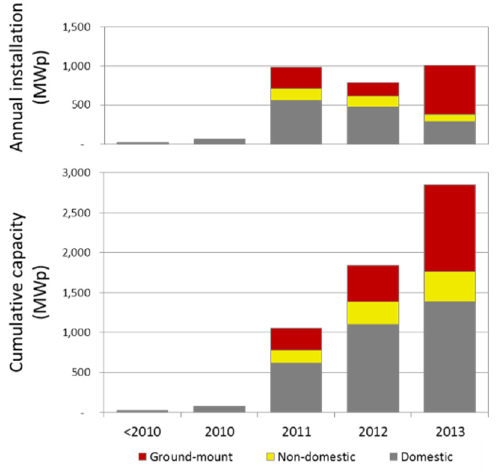
Figure 3. Annual and cumulative deployment of PV in England and Wales.